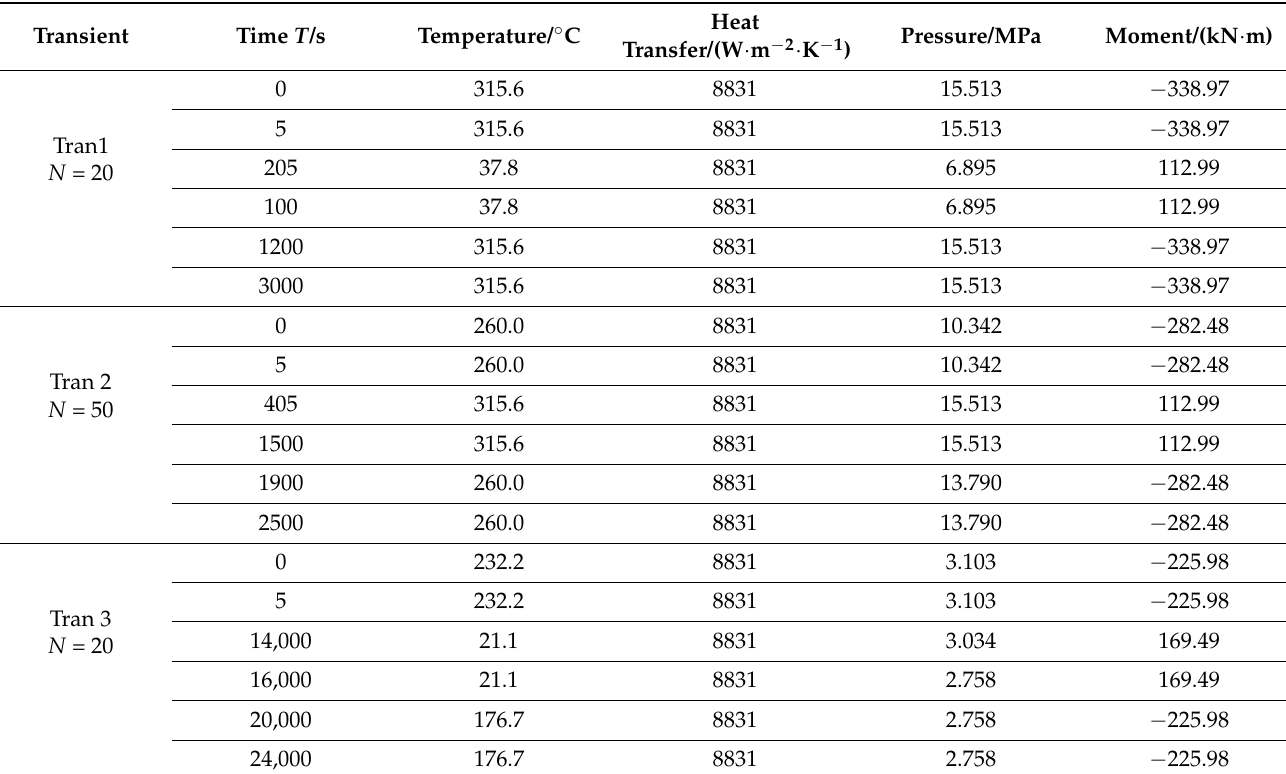
Table 1. Transient data of temperature, pressure, and external load vs. time in sample 1.